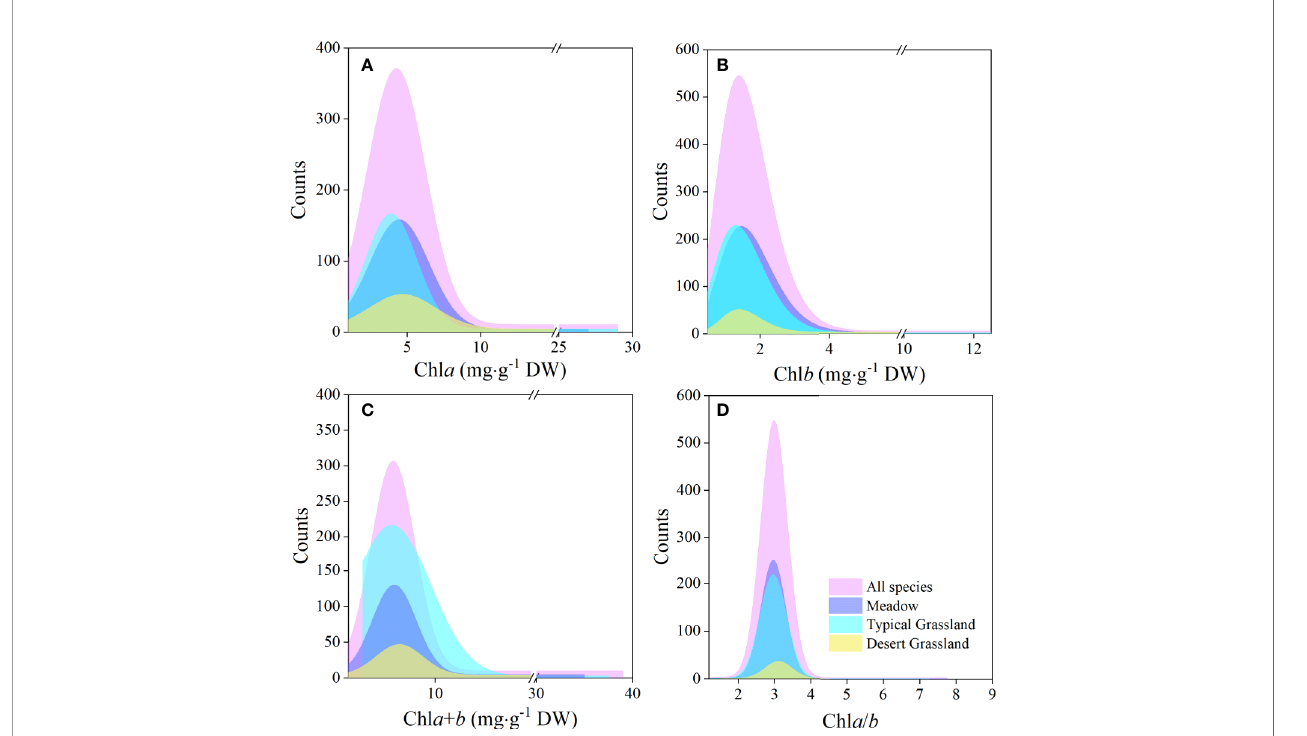
FIGURE 3 | Frequency distributions of chlorophyll concentrations and ratio of the whole northern hemisphere grassland transects and three grassland types, respectively. (A – D) denote distributions of chl a , chl b , chl a + b , and chl a / b , respectively.